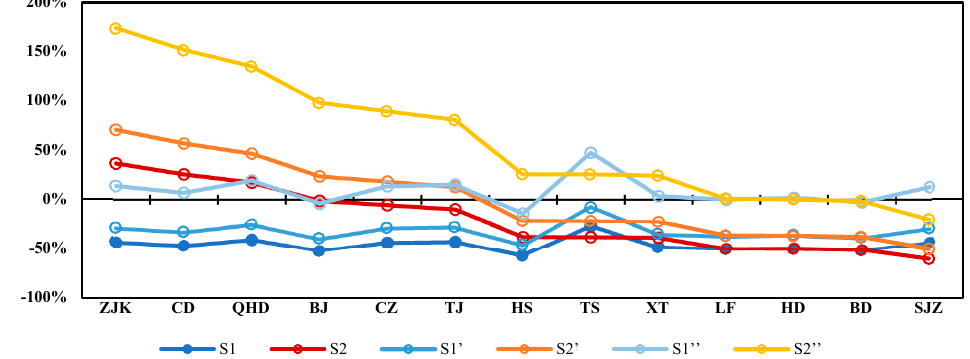
Figure 6. GDP variation ratios under different emission and emission intensity scenarios (S1 and S2, unchanged emission intensity; S1 ′ and S2 ′ , emission intensity reduced by 20%, S1 ″ and S2 ″ , emission intensity reduced by 50%) .